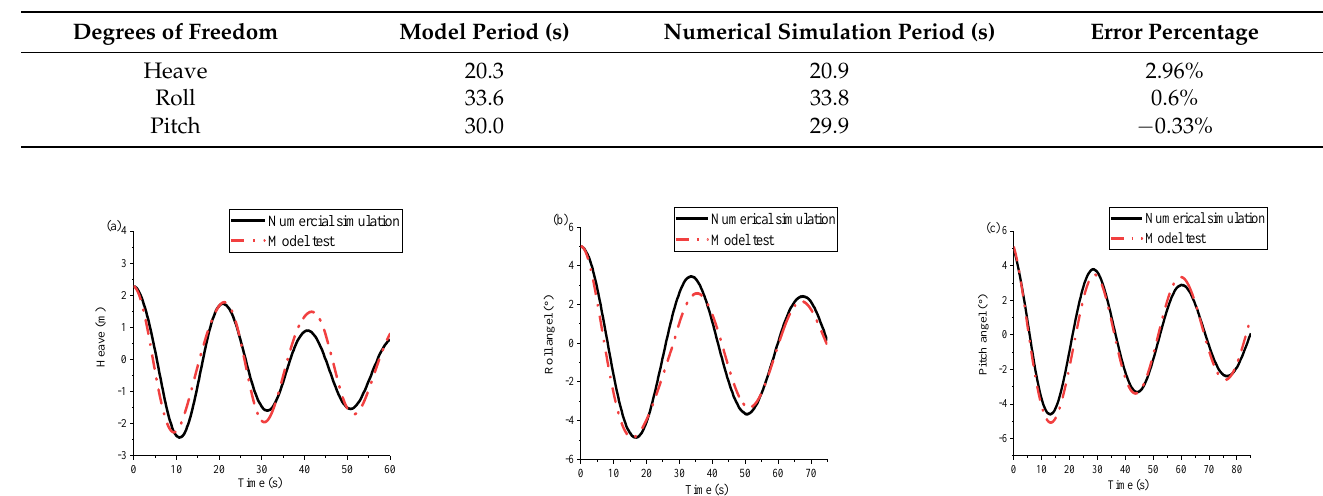
Figure 10. Decay cures in different degrees of freedom. ( a ) Heave. ( b ) Roll. ( c ) Pitch. Table 7. Natural period of platform.